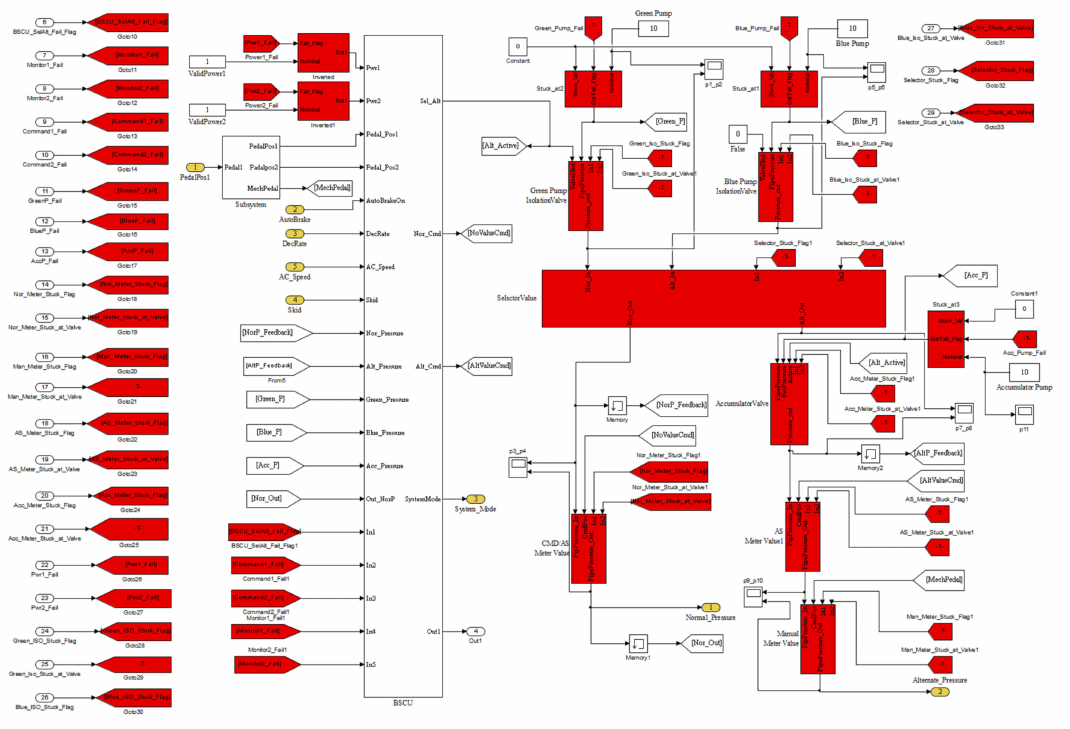
Figure 8. Failure extended simulation model of S18 brake